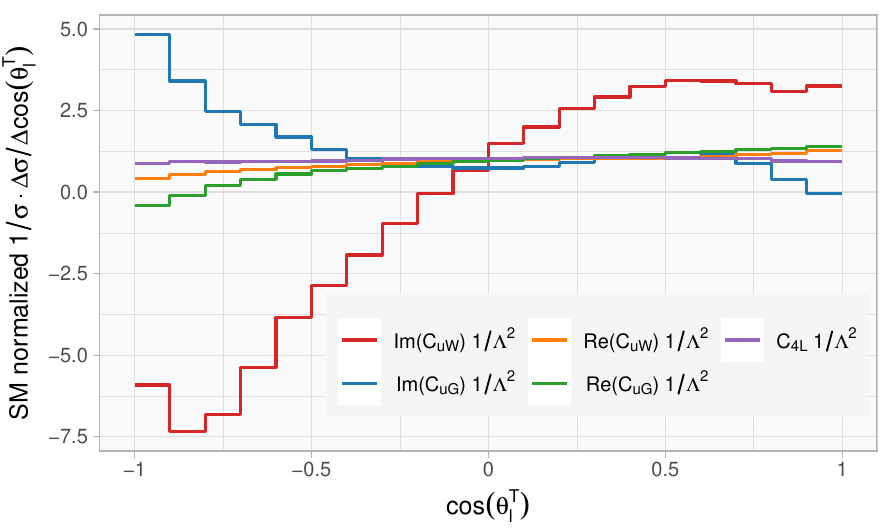
distribution l and C 33 as well uW uG